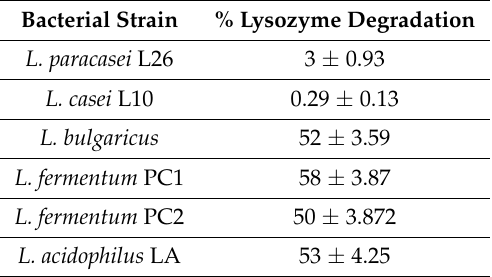
Table 1. Lysozyme sensitivity of cell walls was assayed by measuring the absorbance of bacterial cell wall suspension prior to incubation with lysozyme (4 mg/mL) for 24 h at 37 ◦ C. The absorbance of the cell wall suspensions was measured again and expressed as a percentage of the initial